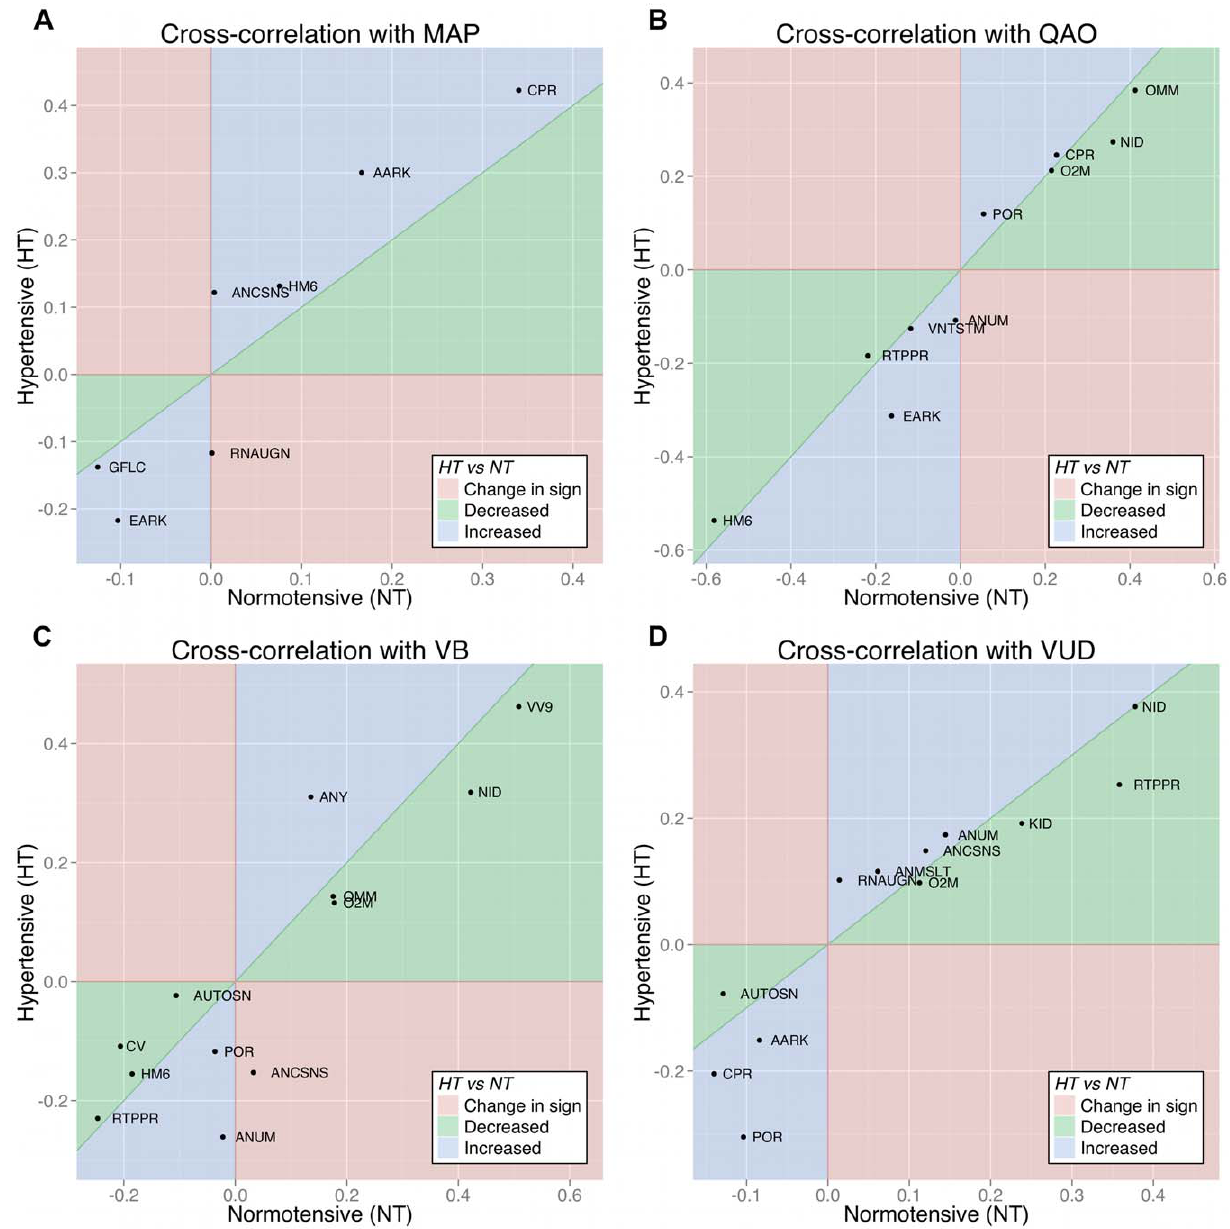
Figure 7. Comparison of correlations between parameters and variables in the normotensive and hypertensive virtual sub- populations. For a given variable, the correlations with each parameter are plotted against the x-axis for the normotensive population, and against the y-axis for the hypertensive population (only correlations c : D c D w 0 : 1 are shown). A: Mean arterial pressure (MAP). B: Cardiac output (QAO). C: Blood volume (VB). D: Rate of urine production (VUD).